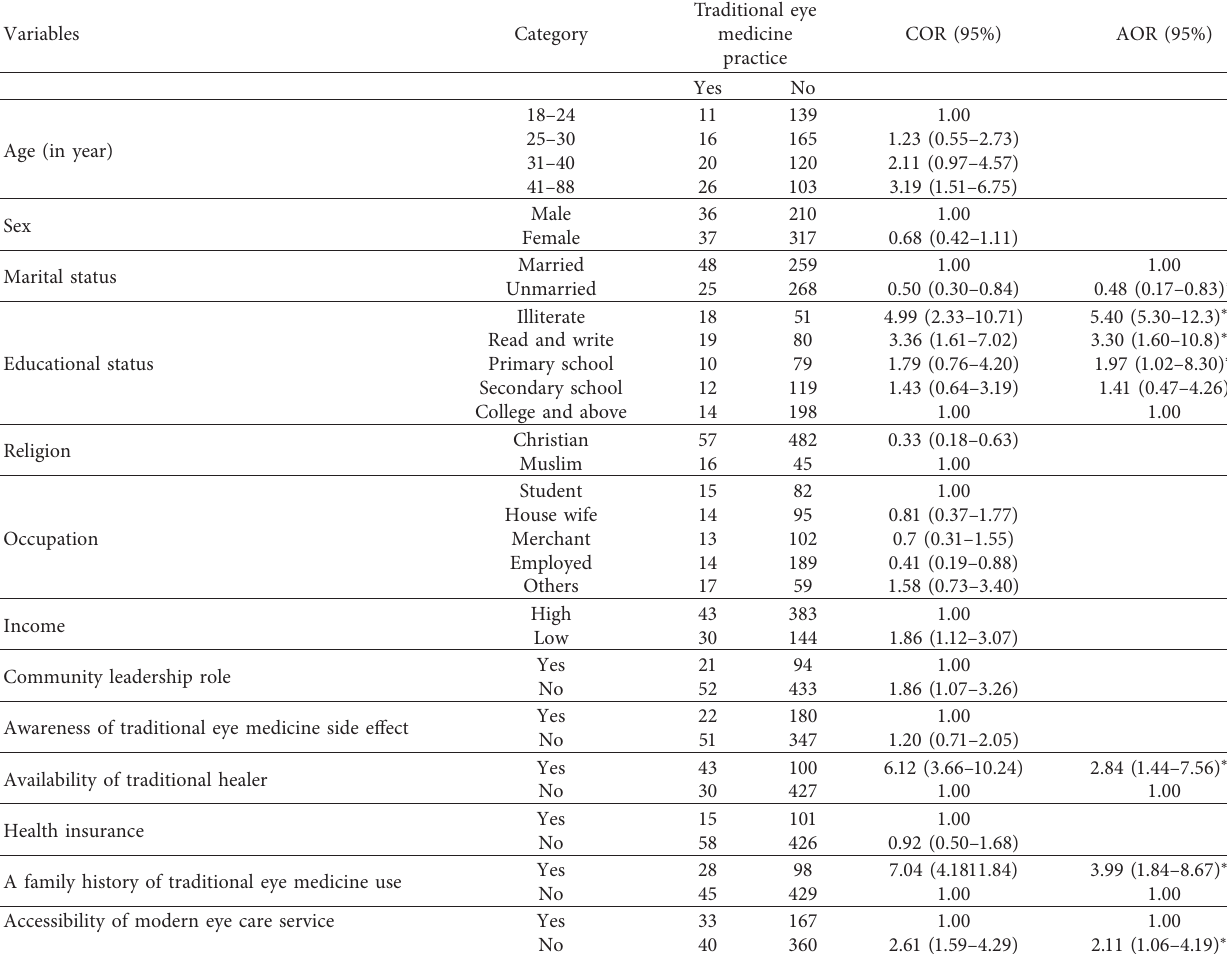
Table 3: Factors associated with traditional eye medicine practice in study participants among adult residents in Gondar city, North West Ethiopia, 2017 ( n � 73, n � number of traditional eye medicine users in the past 2